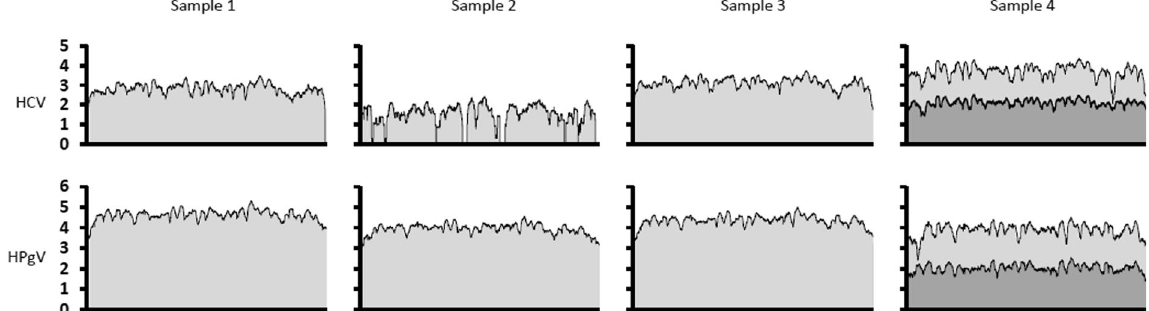
Figure 3. Coverage plots for the HCV and HPgV genomes from the patient sample series. The x-axes represent scaled virus genomes, and log